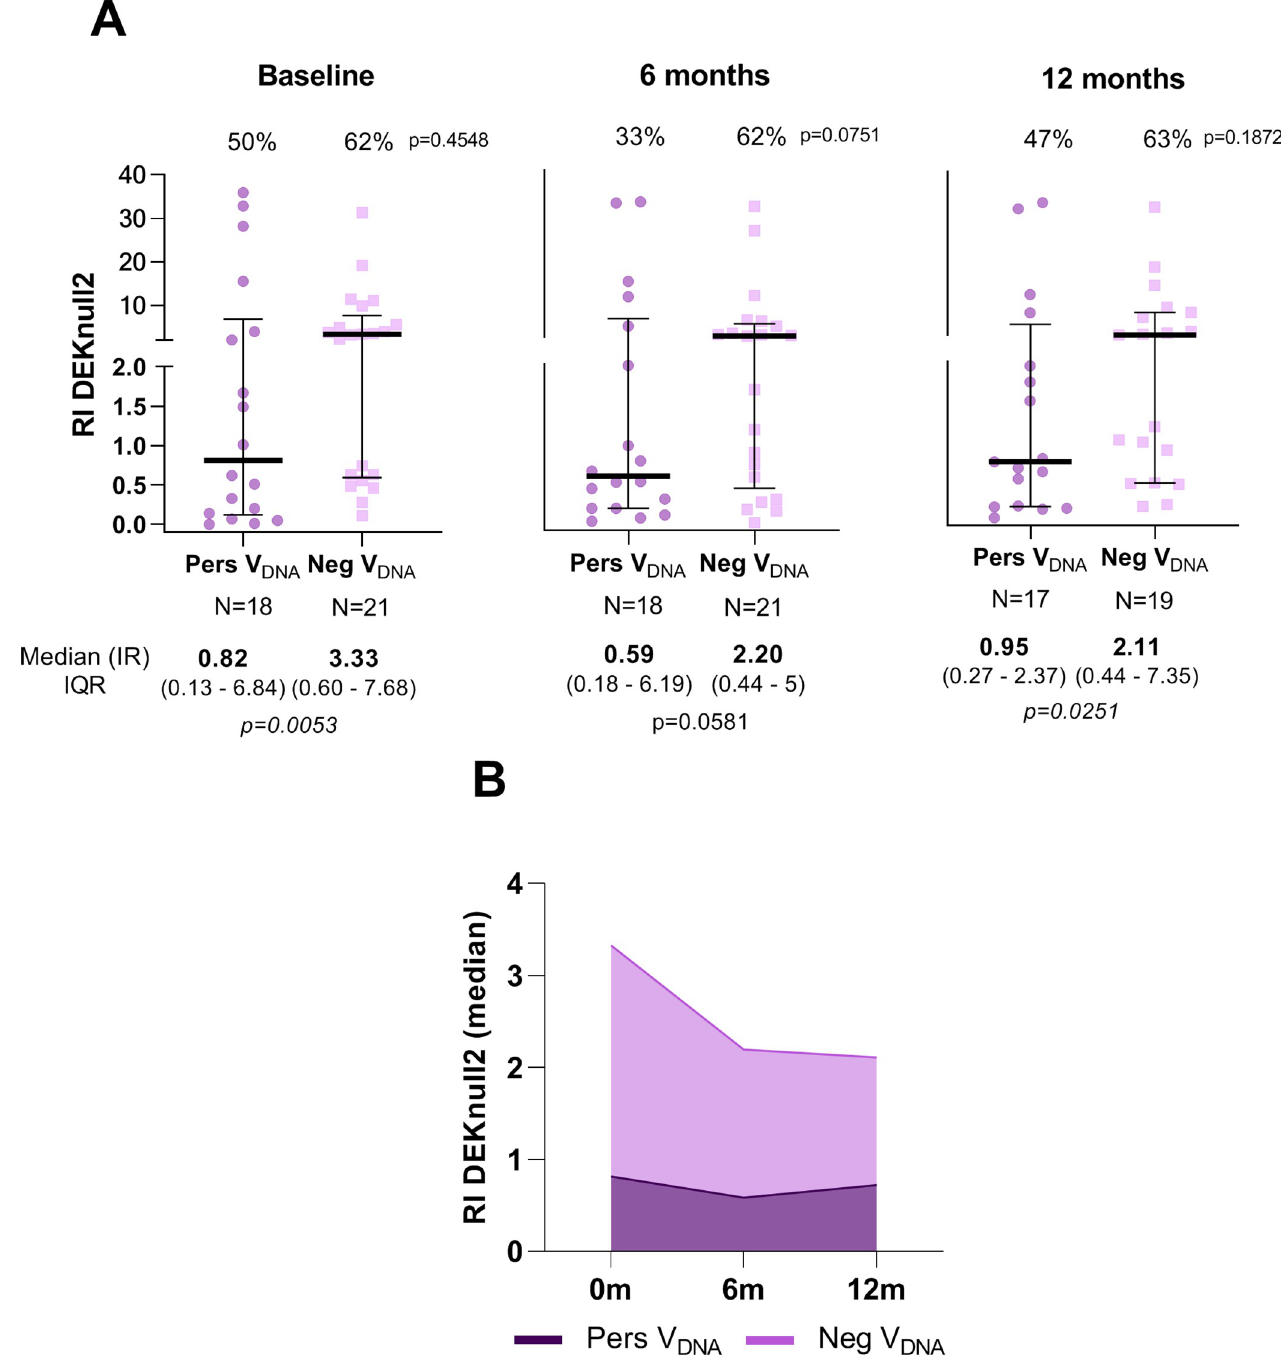
Fig 3. Profile of IgG antibody response against the surface-engineered DEKnull-2 vaccine of P . vivax in individuals with (PersV DNA ) or without (NegV DNA ) persistent viral DNA over the follow-up period. In A, results are shown by cross-sectional surveys (baseline, 6- and 12-month), with individual data points expressed as ELISA Reactivity Index (RI) and shown here as a scatter dot plots with lines showing the median with interquartile range (IQR). In B , medians of RIs overtime for each group. Numbers in the top and bottom of each graphic represent the proportion of responders (%) and median (RI) with IQR values, respectively; p-values for significant difference between groups were included and calculated as described in methods. Reactivity Index (RI) was calculated as described in methods and RI > 1 corresponded to an ELISA-positive